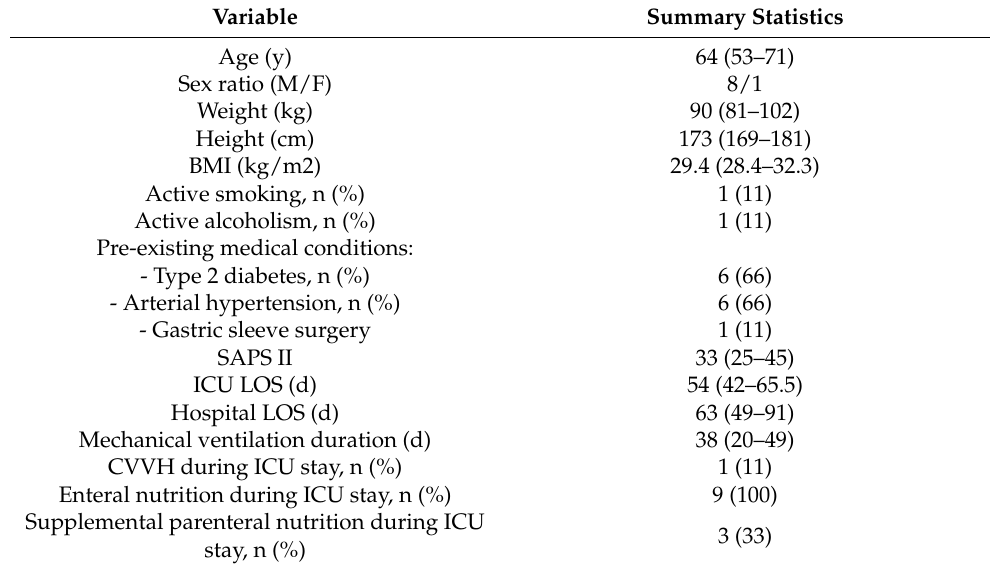
Table 2. Demographic data of COVID-19 patients (N = 9). BMI: body mass index; LOS: length of stay; SAPS II: simplified acute physiology score II; ICU: intensive care unit. Data are expressed as median (P25-P75) or number (%). Variable Summary